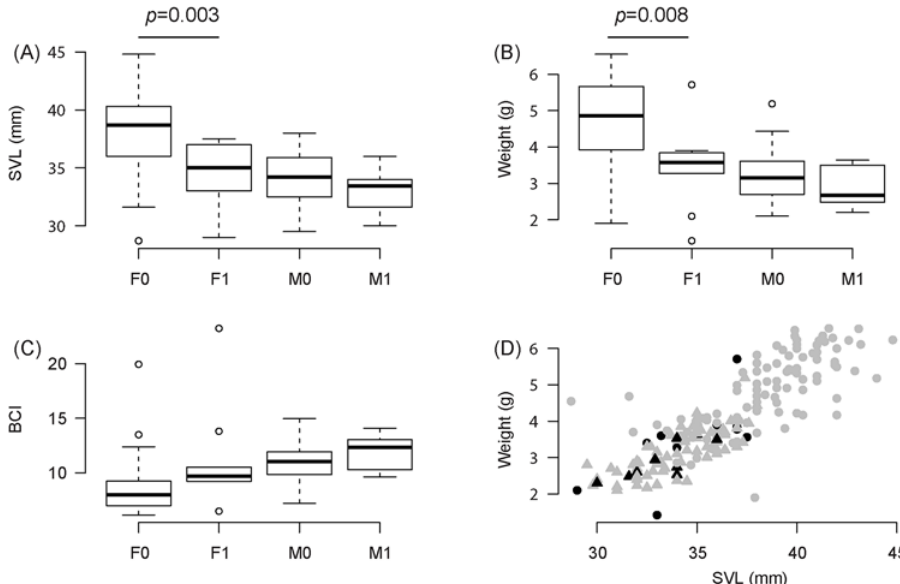
Fig 4. Effect of infection on SVL, weight and BCI for D . tinctorius . Distribution of (A) Snout Vent Length — SVL, (B) weight and (C) Body Condition Index (BCI) defined as the residuals of the regression between SVL and cube root of weight for Dendrobates tinctorius individuals for uninfected (F0; N = 107) and infected (F1; N = 9) females and for uninfected (M0; N = 107) and infected (M1; N = 11) males. Significant p-values of Wilcoxon tests are indicated in the figure. (D) Relationship between SVL (mm) and the cubic root of weight with infected individuals in black and uninfected individuals in grey. Males are indicated by triangles and females by